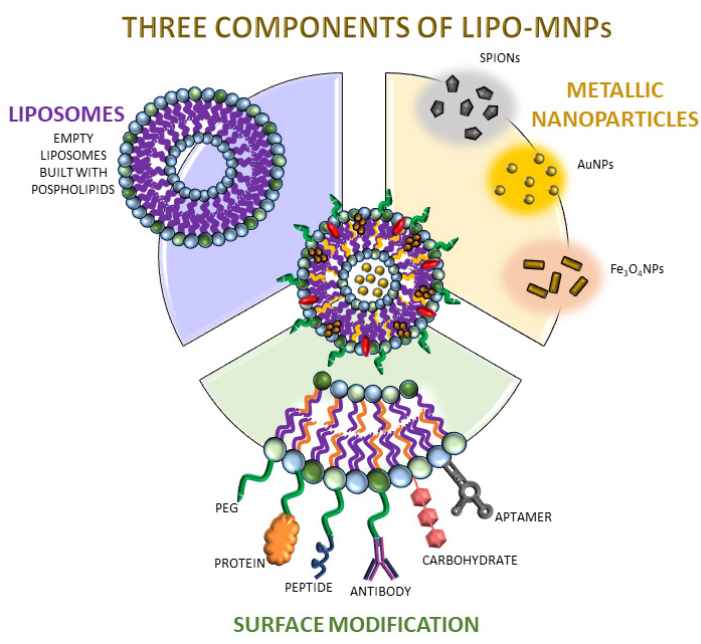
Figure 2. The scheme of liposomal modifications used in therapy support or medical imaging. Three of the most important components were highlighted as crucial parts of LipoMNPs. It presents the empty liposome, which is built with phospholipids, the core of nanostructures containing metallic nanoparticles, and different kinds of surface modifications. Each of these components play a key role in LipoMNPs and has various impacts depending on its target usage. The Lipo-MNPs consist of phospholipids, cholesterol, DSPE-PEG, and MNPs.